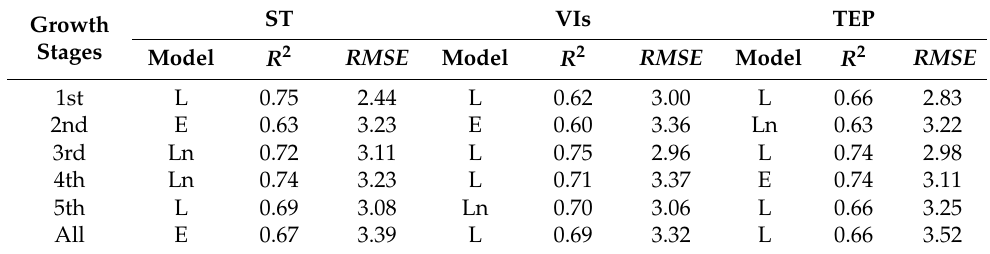
Table 5. Regression analysis and curve fitting results of three parameters versus LCC.